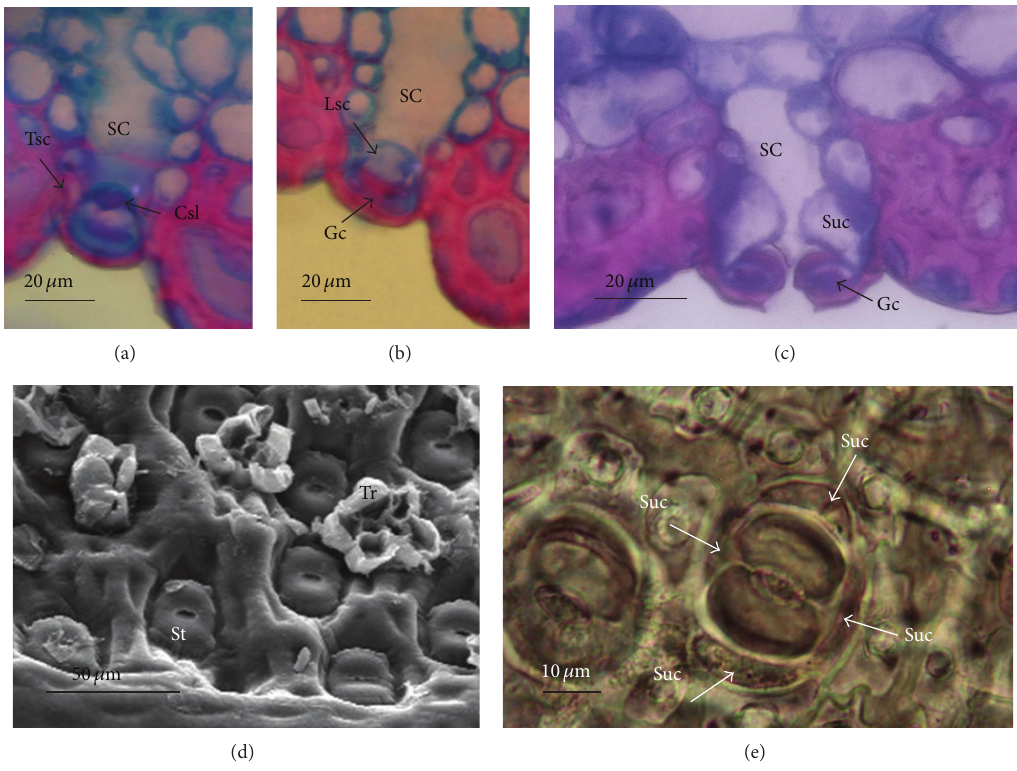
Figure 4: Stomata in the leaf blade of Dyckia brevifolia Baker. ((a) and (b)) Transverse-longitudinal sections with detail of the stomatal structure in individual epidermis depressions between sclereid groups, as shown in light microscopy. (c) Cross section in light microscopy, which shows guard cells (Gc), subsidiary cells (Suc), and substomatal chamber (SC). (d) Stomata frontal view (St) depth in the epidermis and trichomes (Tr), showing part of the shield, as observed in scanning electron microscopy. (e) Frontal view of the subsidiary cells (Sc) of the stomata, as observed in light microscopy. (Lsc = lateral subsidiary cell; Tsc = terminal subsidiary